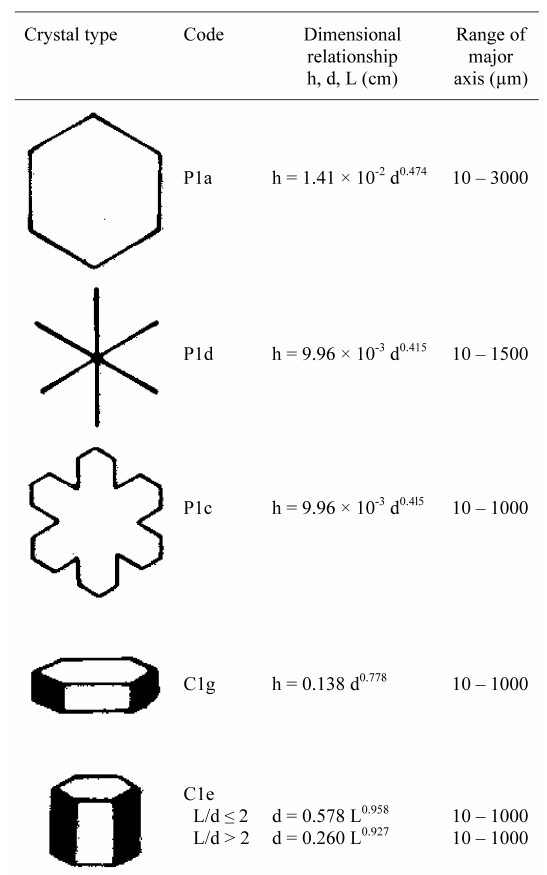
Table 2. Dimensional relationships for the modeled ice crystal types (according to Pruppacher and Klett, 1978). The crystal code refers to the classification of Magono and Lee (1966); Length (L), height (h), and diameter of the circle circumscribed around the crys- tal (d).